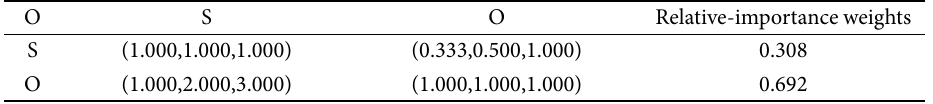
Table 5. The relative-importance weights for the “O” group